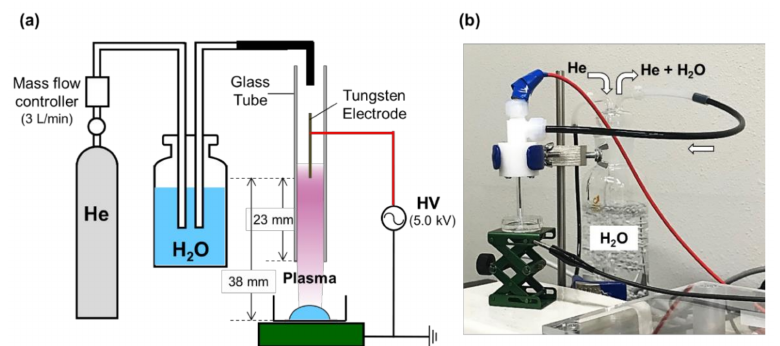
Figure 1. ( a ) Schematic illustration and ( b ) picture of the experimental setup for the helium at- mospheric pressure plasma irradiation system primarily used in this study. In this 8.0 W plasma jet system, He gas passed through pure water and moist He with 100% relative humidity served as the source gas. The applied peak-to-peak voltage (5.0 kV), the distance between the electrodes (38 mm), and the distance between the powered electrode and the edge of the glass tube (23 mm) were